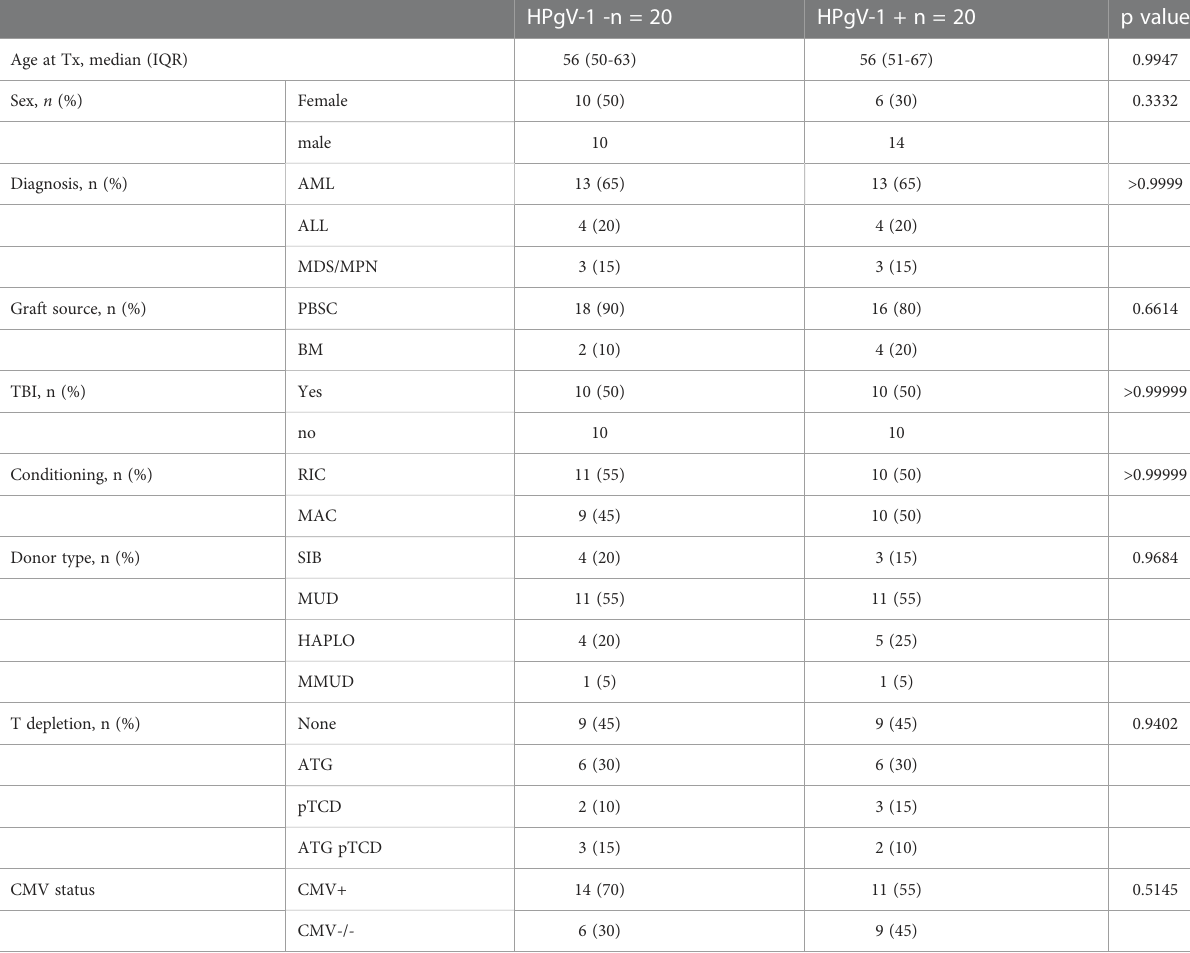
TABLE 1 Clinical characteristics of HPgV-1-non viremic (HPgV-1-) and HPgV-1-viremic (HPgV-1+) allo-HSCT